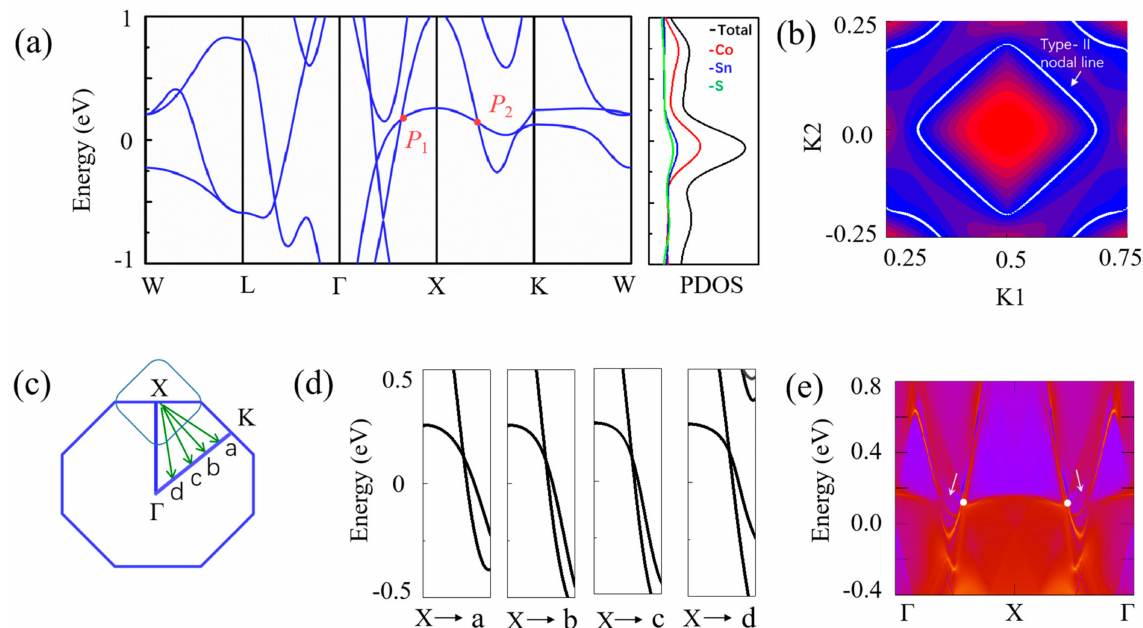
Figure 2. ( a ) Electronic band structure and the projected density of states (PDOS) of Sn 2 CoS without SOC. Two crossing points near the Fermi level along the Γ − X − K path have been labeled as P 1 and P 2 , respectively. ( b ) The nodal loop in Sn 2 CoS. ( c ) Illustration of the nodal loop. The points a , b , c , and d are equally spaced between K and Γ . ( d ) Band structures along the k -paths as indicated in ( c ). ( e ) The surface state band structure on the (1 1 0) of Sn 2 CoS without